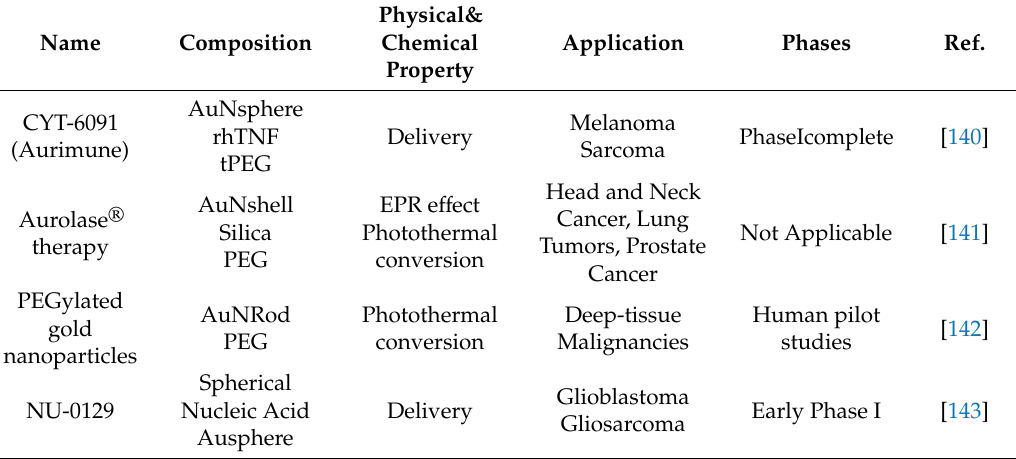
Table 2. AuNPs are used for clinical trials in tumor therapy and